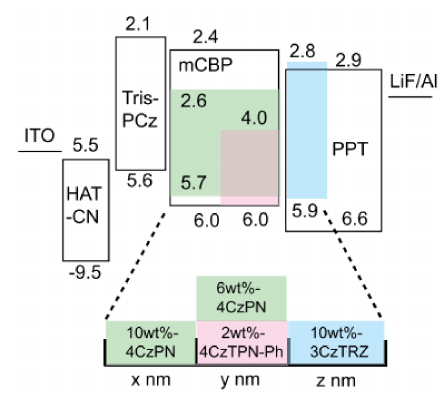
Figure 2. The WOLED structures and energy level diagram. Reproduced with permission from [55], AIP Publishing LLC,